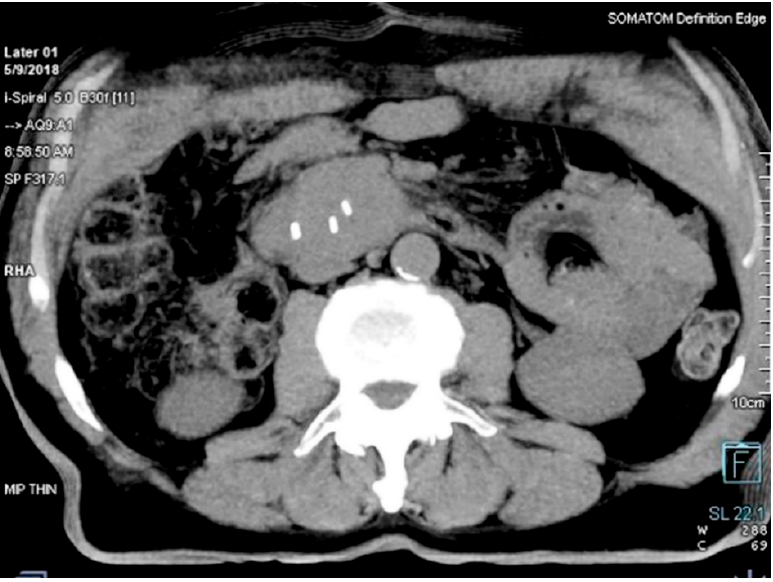
Figure 2. Position of the Beacon ® transponders in the tumor on a MSCT scan.